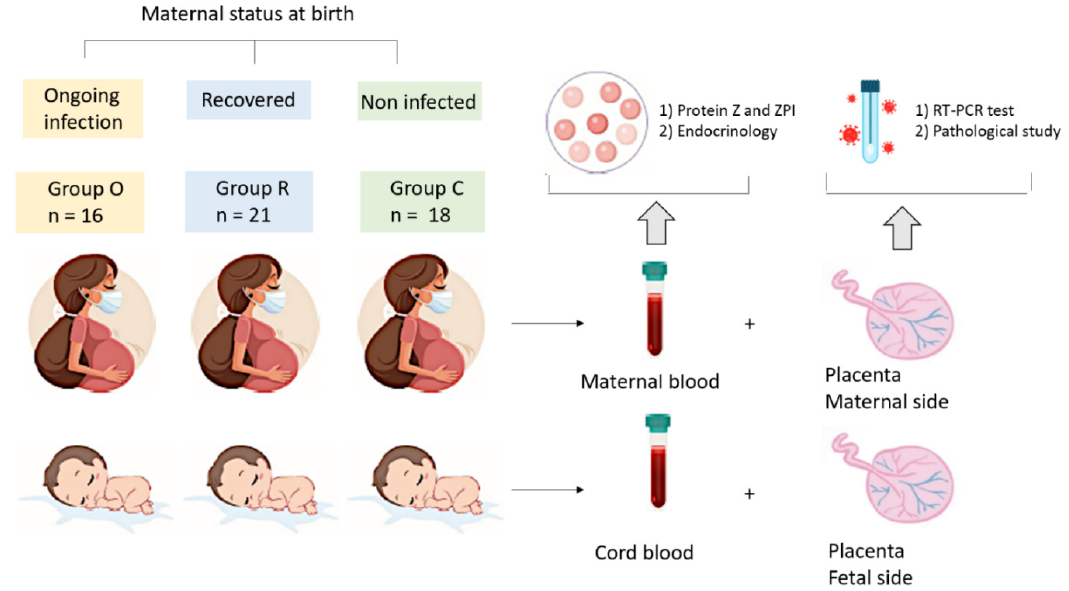
Figure 1. Study outline of the recruitment of neonates and mothers.